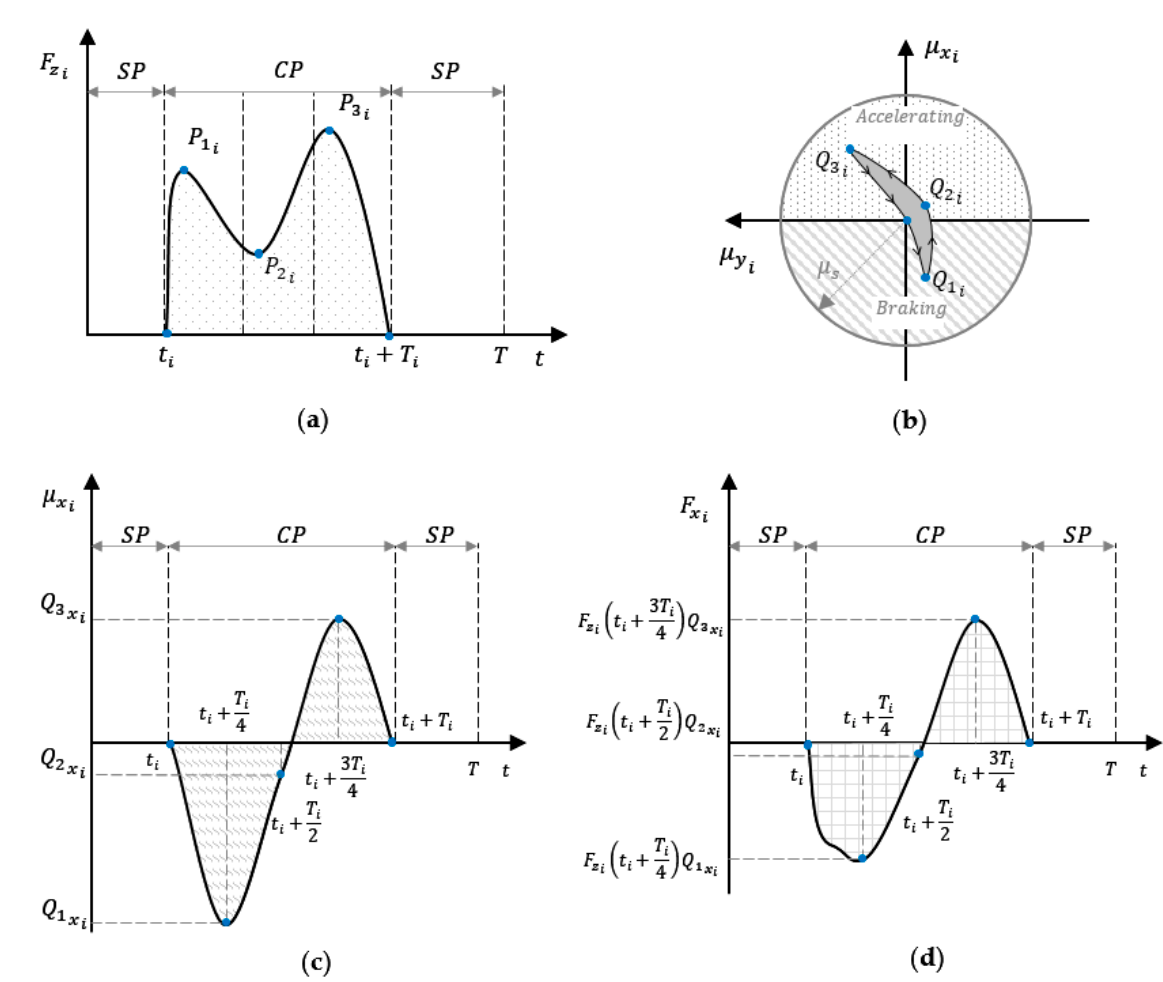
Figure 3. ( a ) Vertical ground force; ( b ) trend of the coefficient of adhesion inside the static friction cone; ( c ) longitudinal adhesion coefficient as a function of time; and ( d ) longitudinal ground force.